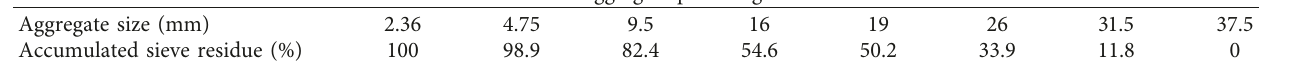
Table 6: Coarse aggregate particle gradation.